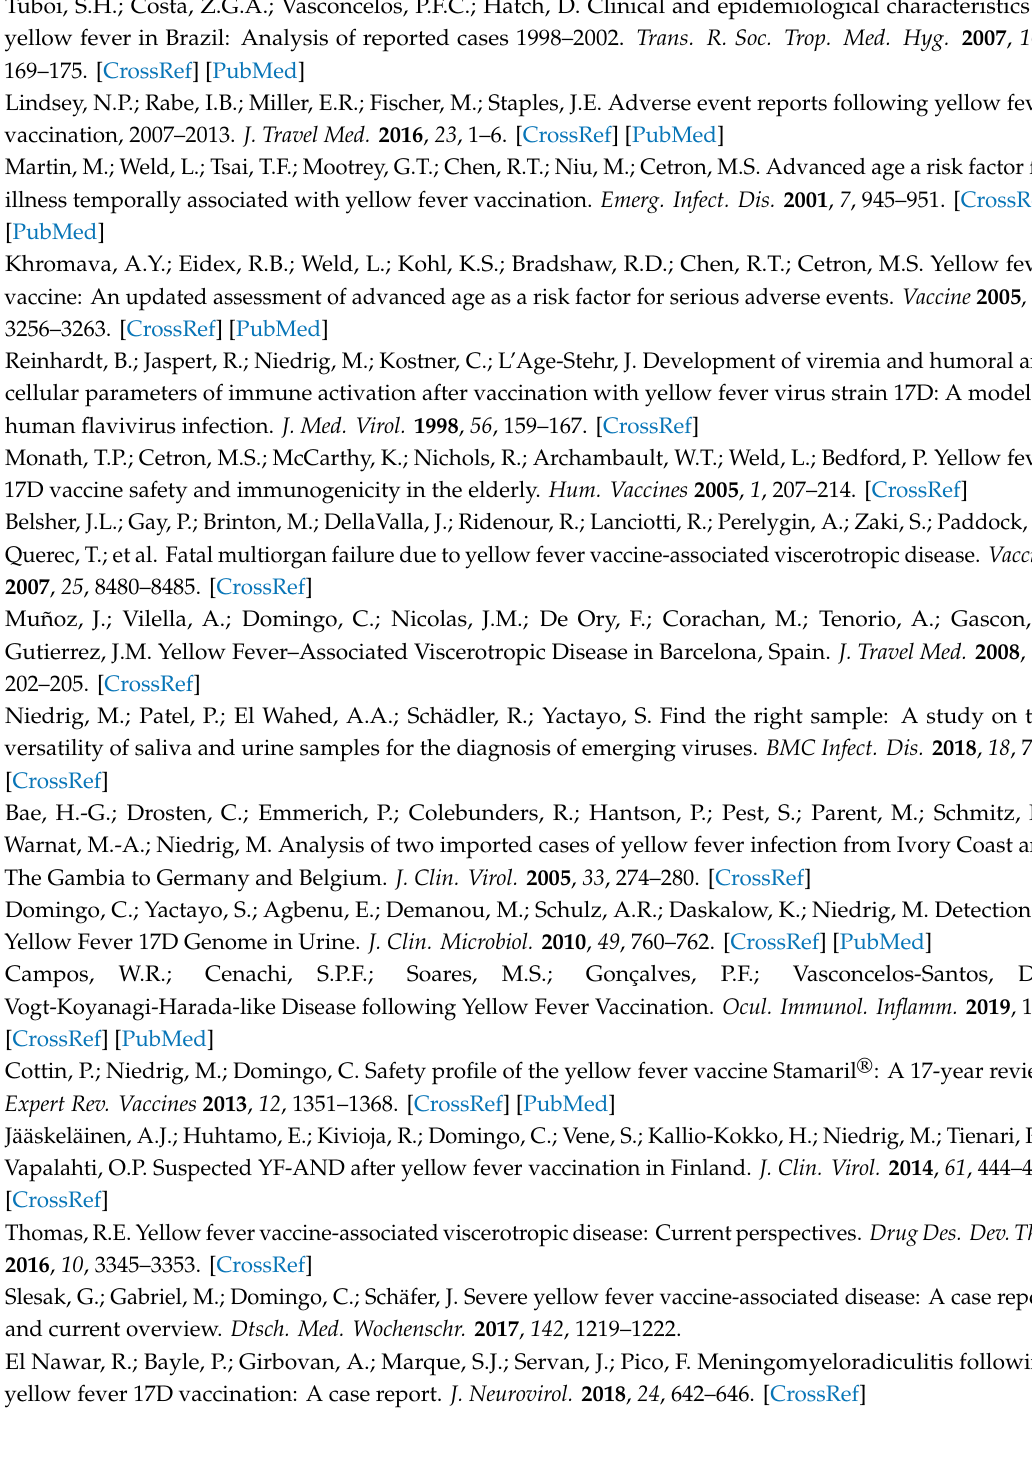
YFV: Yellow fever virus; YEL-AVD: yellow fever vaccine associated viscerotropic disease; YF-AEFI: yellow